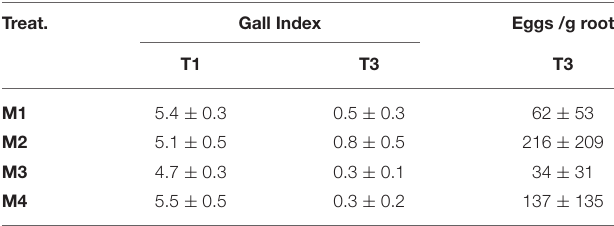
TABLE 5 | Average values and standard errors of root galling index in the plants harvested before (T1) and after biodisinfestation treatments (T3).